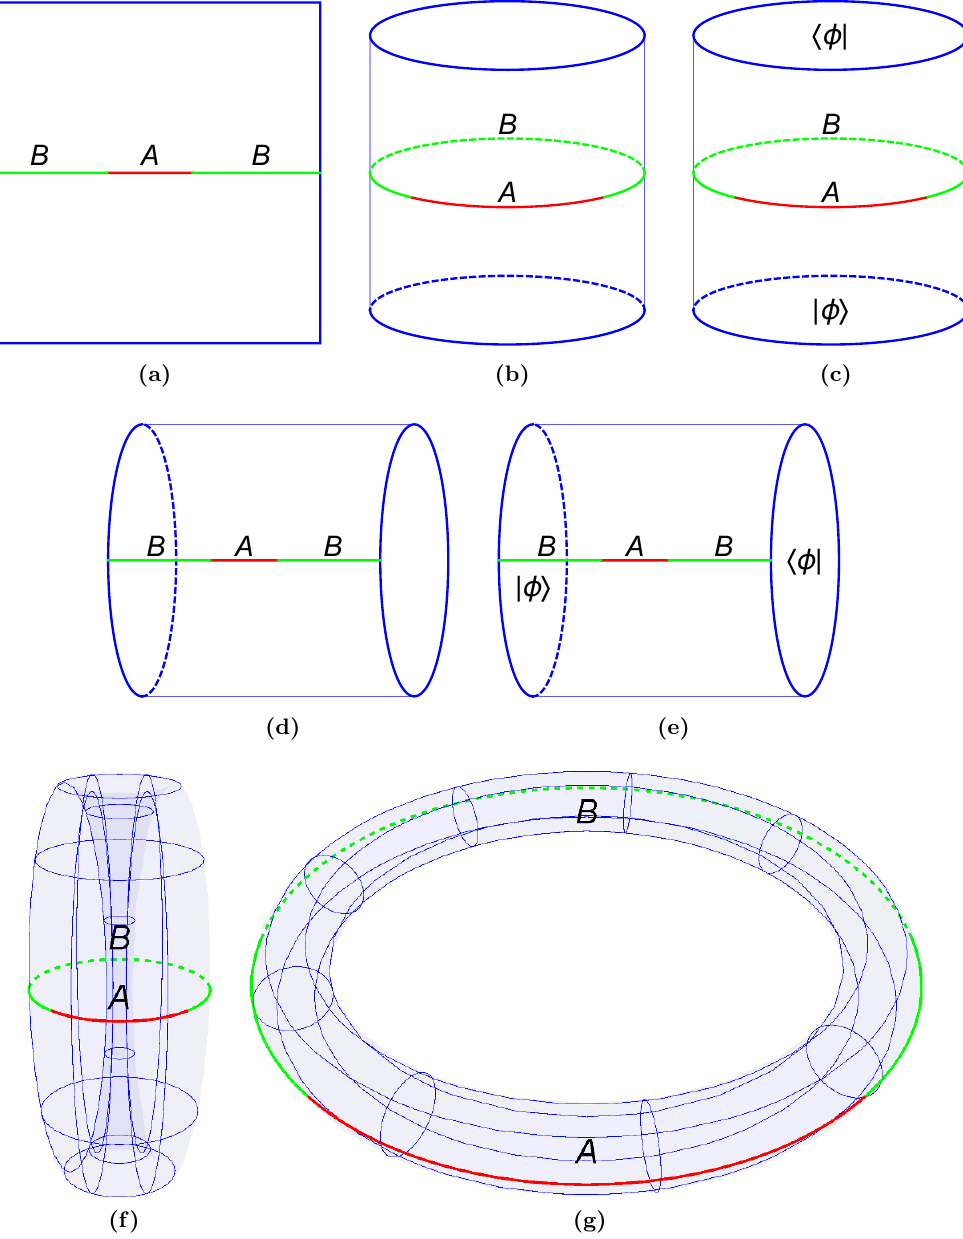
Figure 1. The Riemann surfaces as environments for the interval A = [0 ; ‘ ] we consider in this paper. (a) A complex plane R ( ; ). (b) A vertical cylinder R ( L ). (c) A vertical cylinder capped with operators R ( L; (cid:30) ). (d) A horizontal cylinder R ( (cid:12) ). (e) A horizontal cylinder capped with operators R ( (cid:12); (cid:30) ). (f) A fat torus R ( L; q = e (cid:0) 2 (cid:25)(cid:12)=L ). (g) A thin torus R ( (cid:12); p = e (cid:0) 2 (cid:25)L=(cid:12) ).